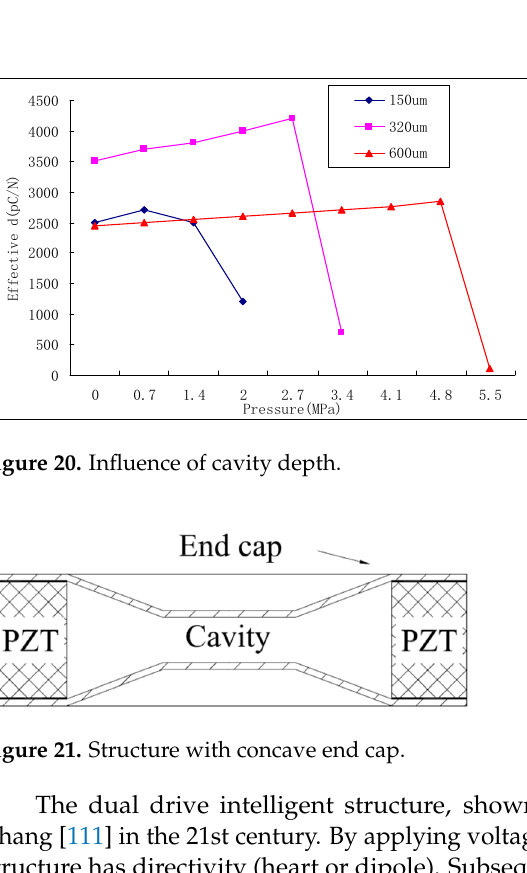
14 of 25 Figure 18. Hub cymbal transducer. Figure 19. Structure diagram of cymbal with piezoelectric ring and metal ring. If cymbal intelligent structure is to be used in underwater applications, especially in deep-water high-pressure areas, its pressure resistance must be studied. According to the research of Erman Uzgur [108], the limit pressure of the intelligent structure is determined by the effective piezoelectric coefficient. As the cavity depth changes, as shown in Figure 13, the limit pressure of intelligent structure increases. And the material properties and the device diameter will have an impact on the ultimate pressure. In order to meet the pressure requirements in deep-water regimes and broaden the application scope, a piezoelectric ceramic ring is introduced as the core component to im-